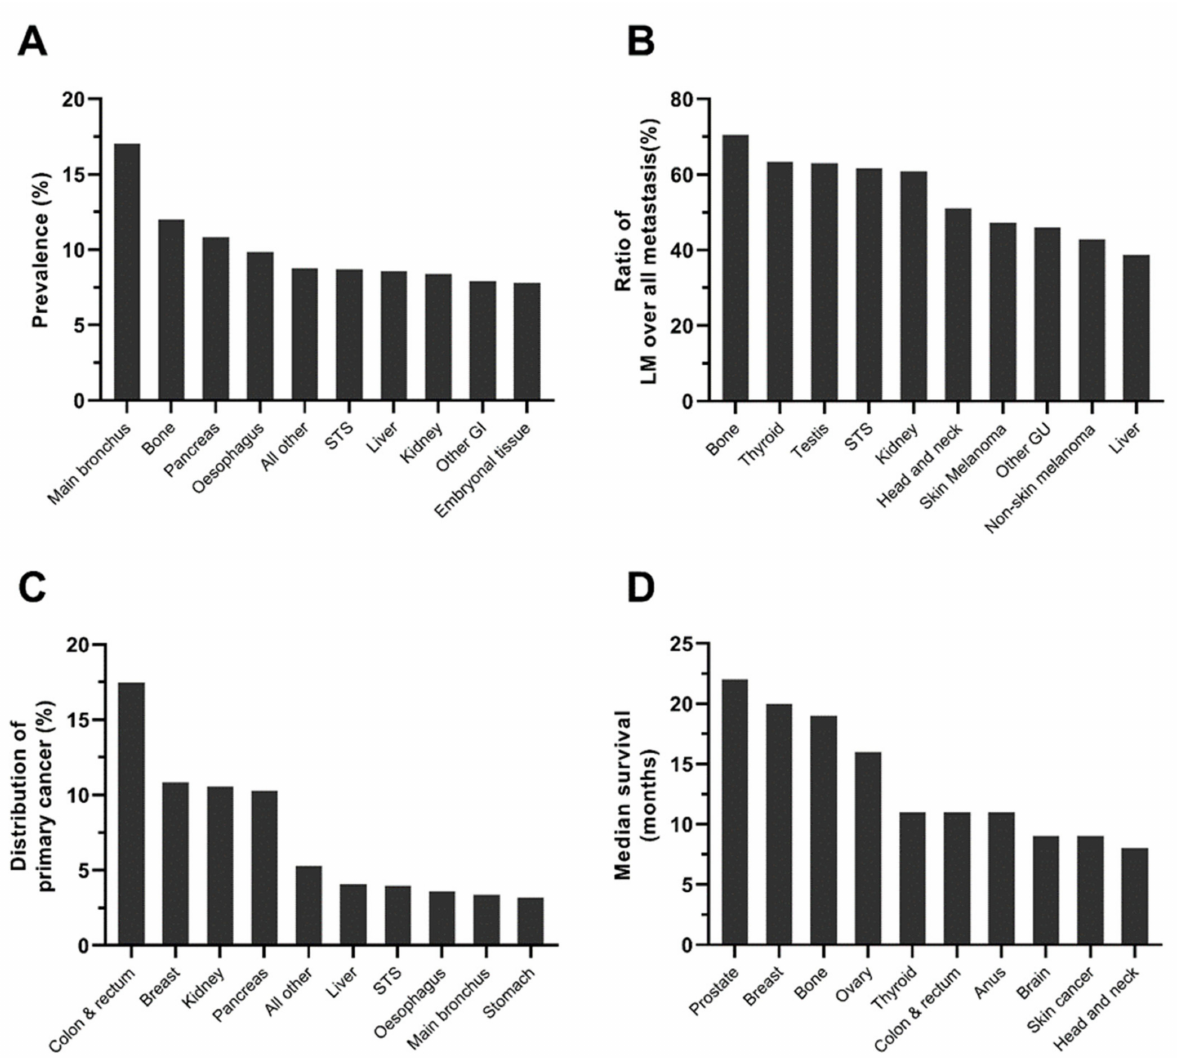
Figure 1. Prevalence and prognosis of sLM cases by primary cancer. ( A ) Prevalence of synchronous sLM by cancer type in all cancer patients (including metastatic and non-metastatic cancer patients); ( B ) Ratio of synchronous sLM by cancer type in patients with metastatic lesions; ( C ) Distribution of primary cancer in patients with sLM; ( D ) Median survival of cancer patients with sLM. Abbreviations: STS: soft tissue sarcoma; GI: gastrointestinal cancer; GU: genitourinary